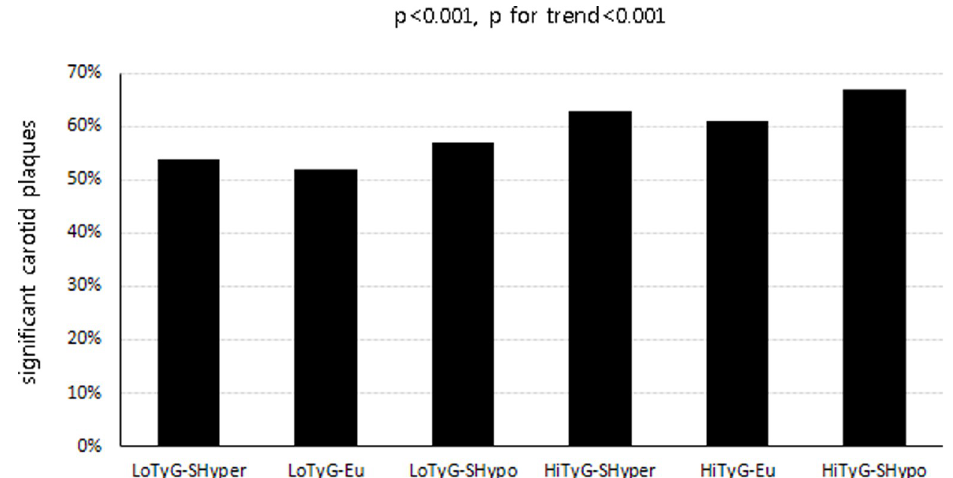
Fig 1. Proportion of significant carotid plaques according to triglyceride-glucose index and thyroid function status.